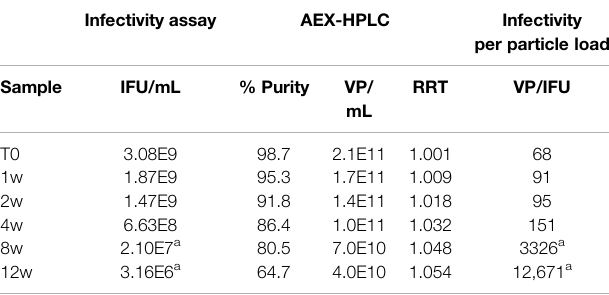
TABLE 1 | Infectivity & AEX-HPLC data from the AdC68 #1 accelerated stability time course. Infectivity assay AEX-HPLC Infectivity